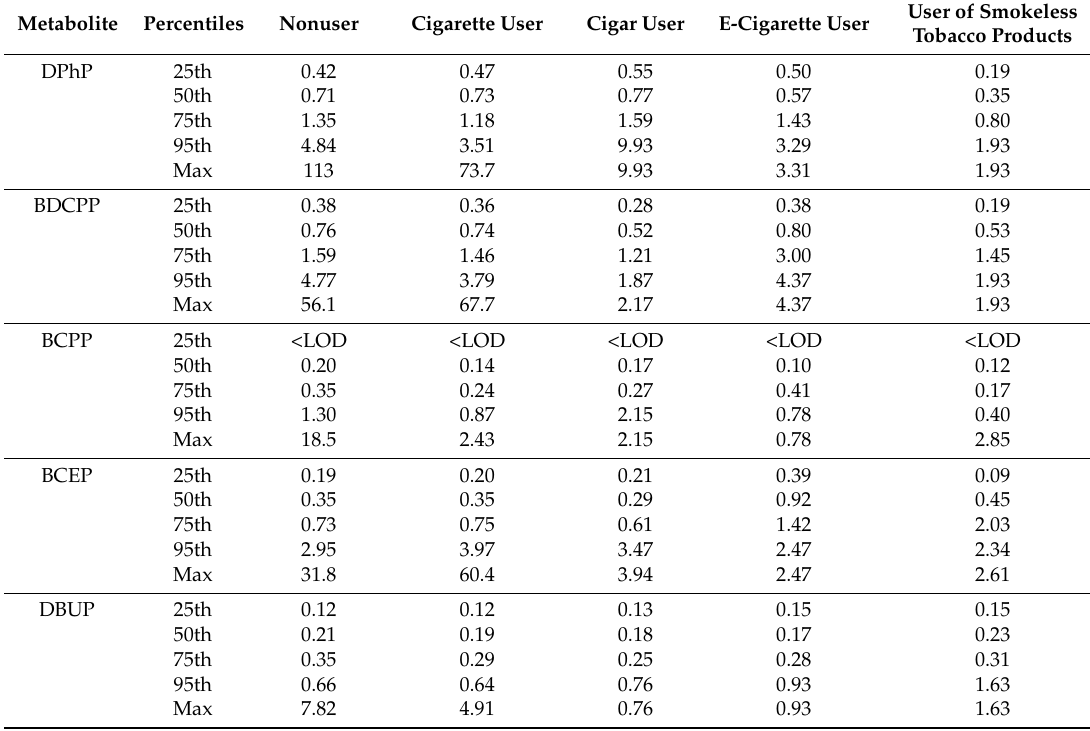
Table 3. Selected percentiles of urinary metabolites of FRs (in µ g/g creatinine).